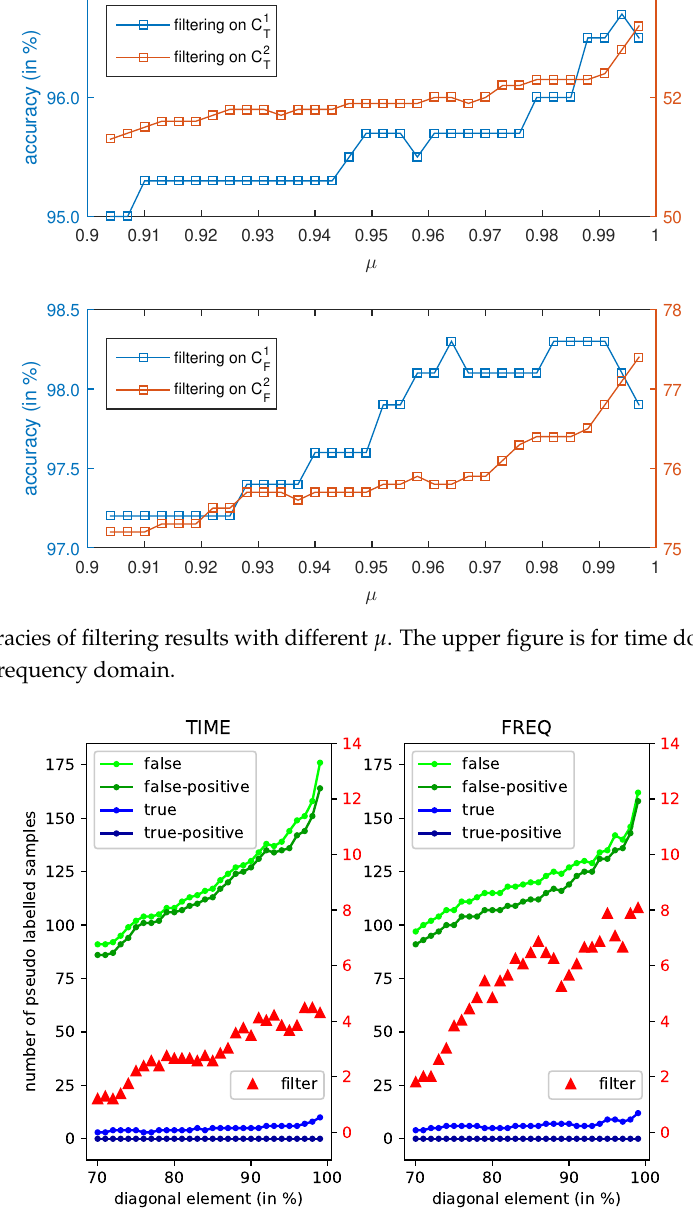
Figure 10. The influences on Bayesian filtering and pseudo-labeling algorithm of different diagonal elements. The right axis corresponds to filter . The left axis corresponds to false , false-positive , true , true-positive . The left figure is for time domain, while the right one for frequency